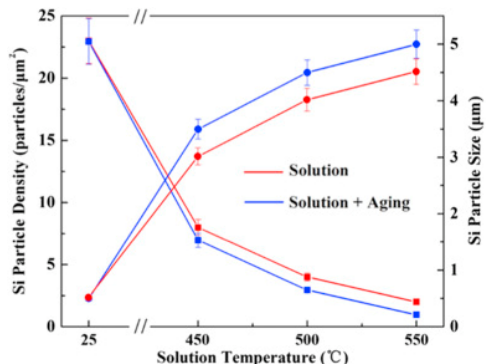
Figure 44. Plot showing the Si particle density and size as a function of annealing treatment for AlSi10Mg SLM samples, calculated from scanning electron microscopy images [160]. Adapted with permission from Elsevier Science Ltd. under the license number 4803740322935 (Figure 5 [76]), dated